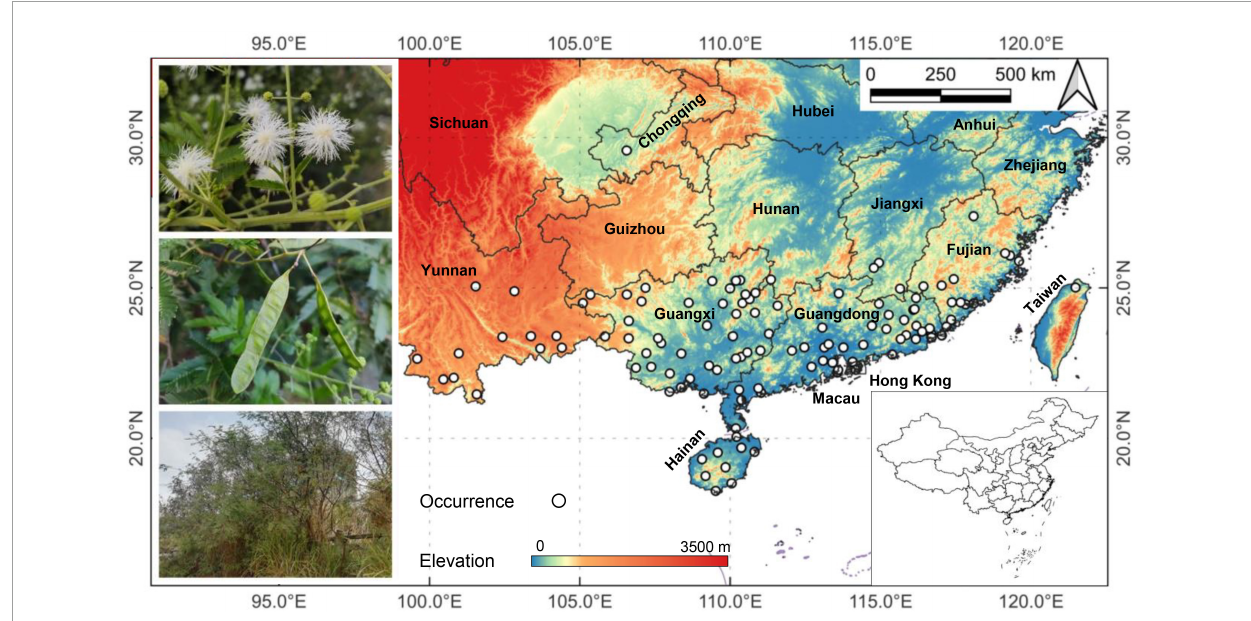
FIGURE1 Locations of 125 selected occurrence records (shown by white circles) of Mimosa bimucronata in China in relation to elevation. Images on the left show the species’ flowers, fruits and a small patch of the